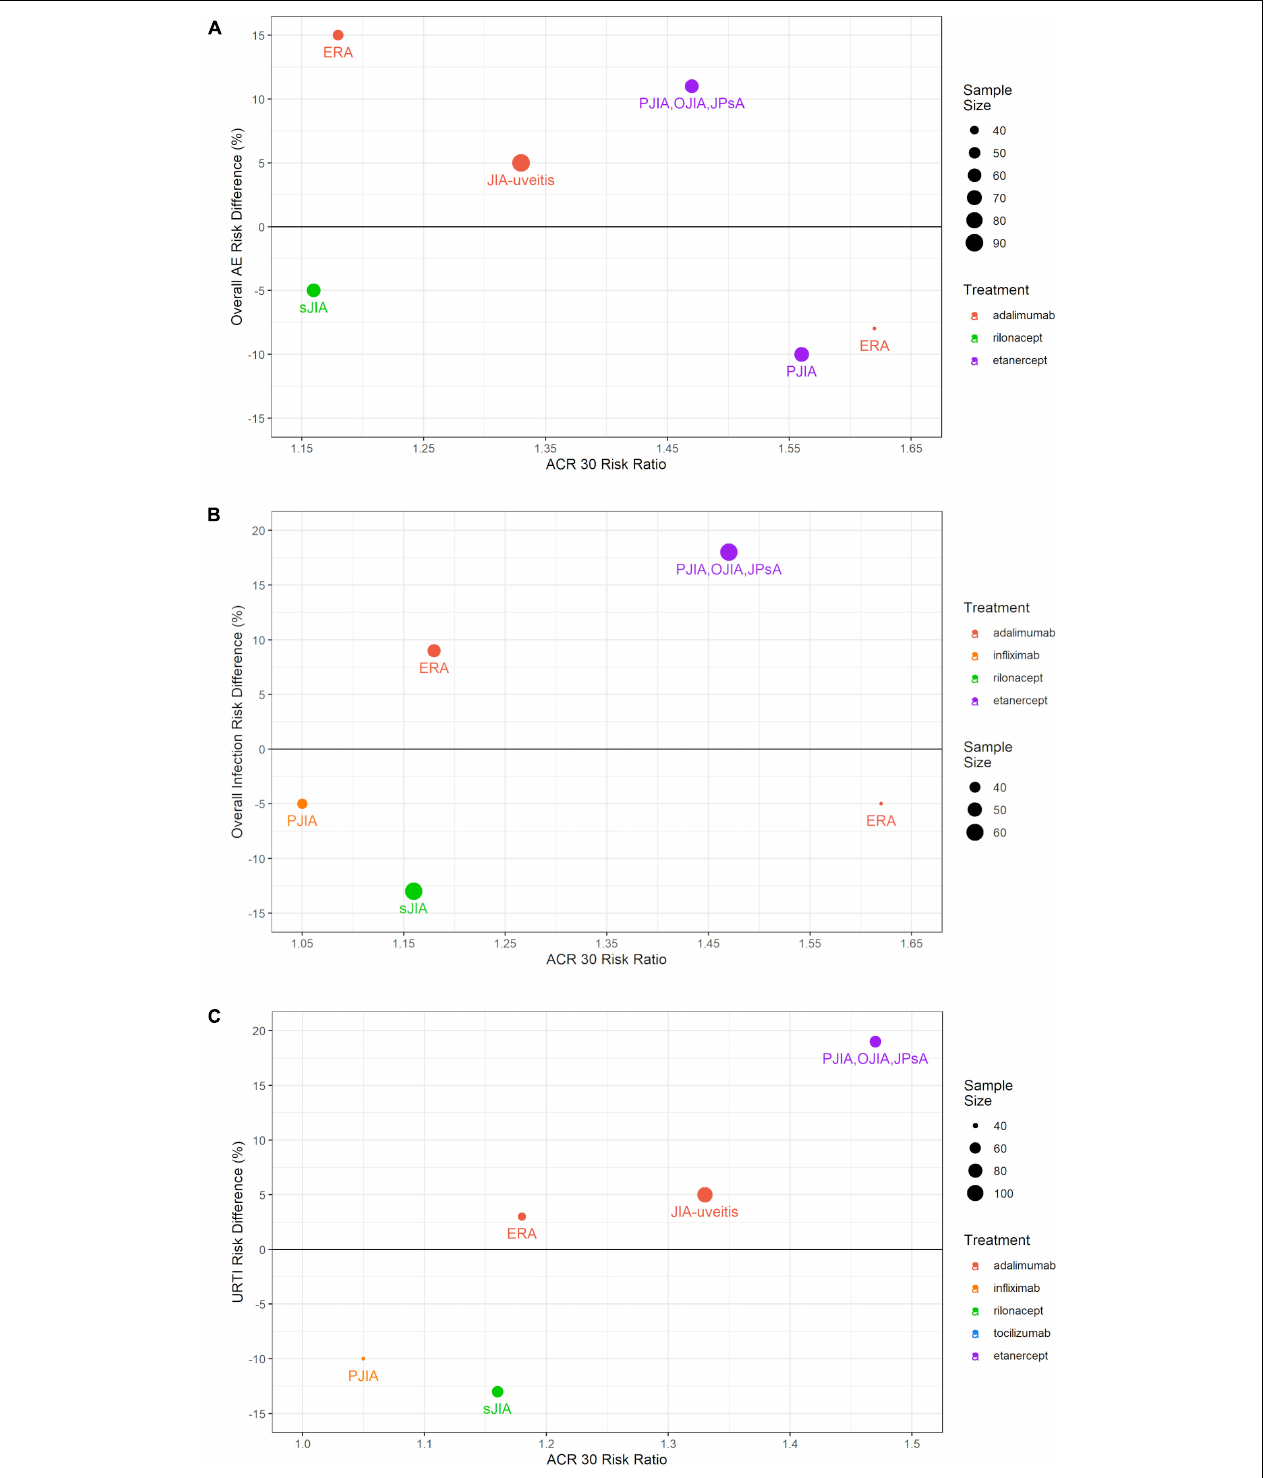
FIGURE 5 | Comparing efficacy (ACR Pedi 30 RRs) against safety (RD) in the RCTs that reported both outcomes. (A) ACR Pedi 30 RR vs. any AE RD; (B) ACR Pedi 30 RR vs. any infection RD; (C) ACR Pedi 30 RR vs. URTI RD. The size of each dot corresponds to the sample size. The color of each dot corresponds to the treatment used in the studied arm. ACR Pedi, American College of Rheumatology pediatric responses; RCT, randomized controlled trial; RD, risk difference; URTI, upper respiratory tract infection.